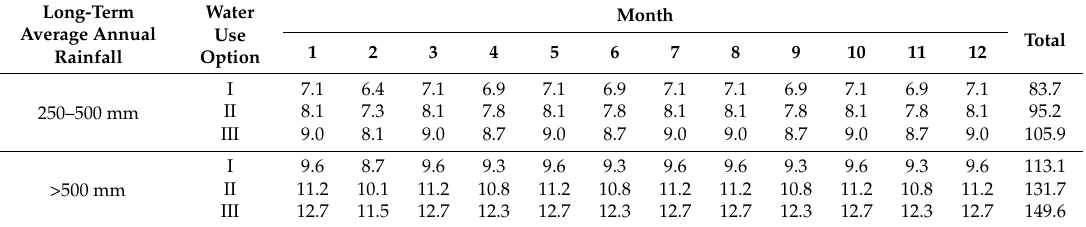
Table 4. Monthly rural household water use (m 3 ) based on different consumption use